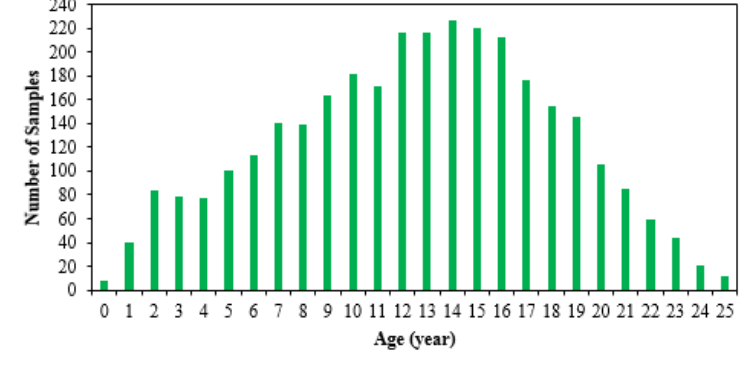
Figure 3 . Distribution of oil sample data. Figure 3. Distribution of oil sample data. Table 2 . Computed HI by age and zones. Table 2. Computed HI by age and